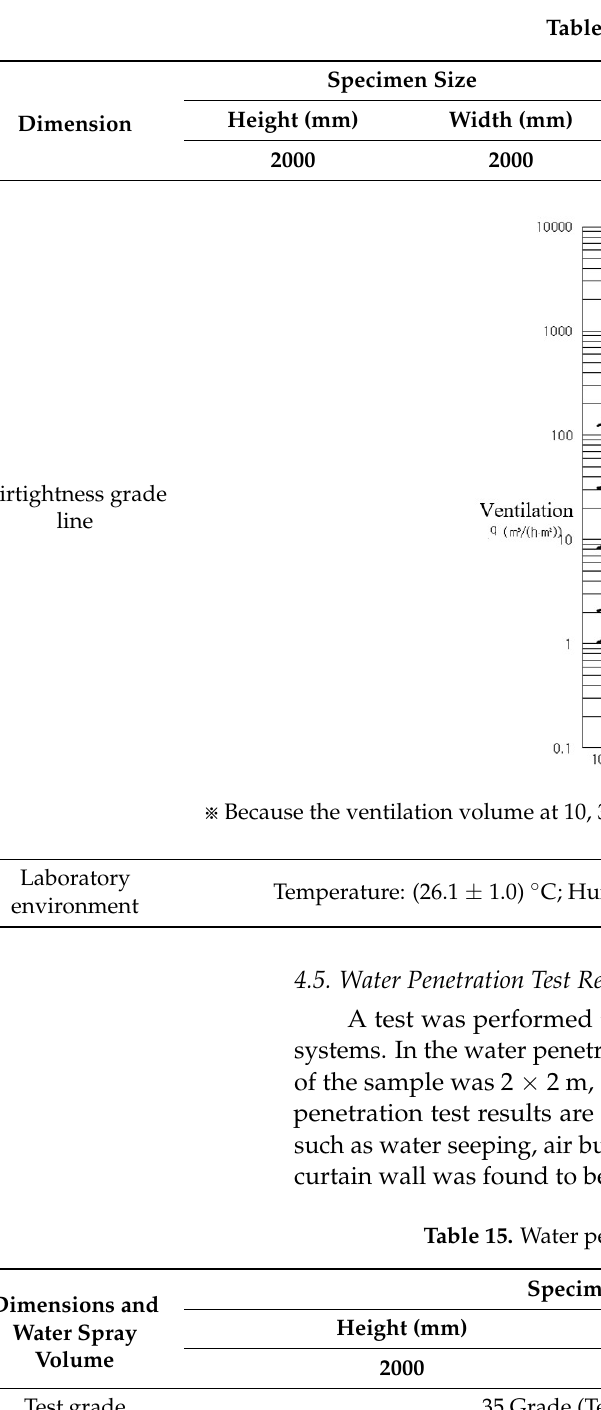
Table 15. Water penetration test results.